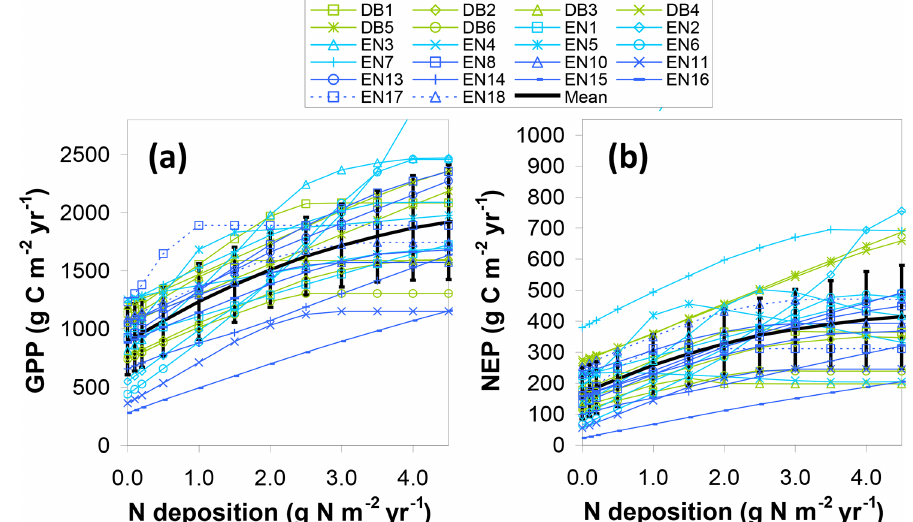
Figure 9. Simulated BASFOR model sensitivity to N deposition of (a) gross primary productivity (GPP) and (b) net ecosystem productivity (NEP) for 22 forest sites (with mean ± standard deviation), derived from a purely modelled approach (not involving measured EC flux data). Each site was modelled using a range of N dep values from 0 to 4.5gNm − 2 yr − 1 (constant N dep over the lifetime of the stands). DB: deciduous broadleaf; EN: coniferous evergreen